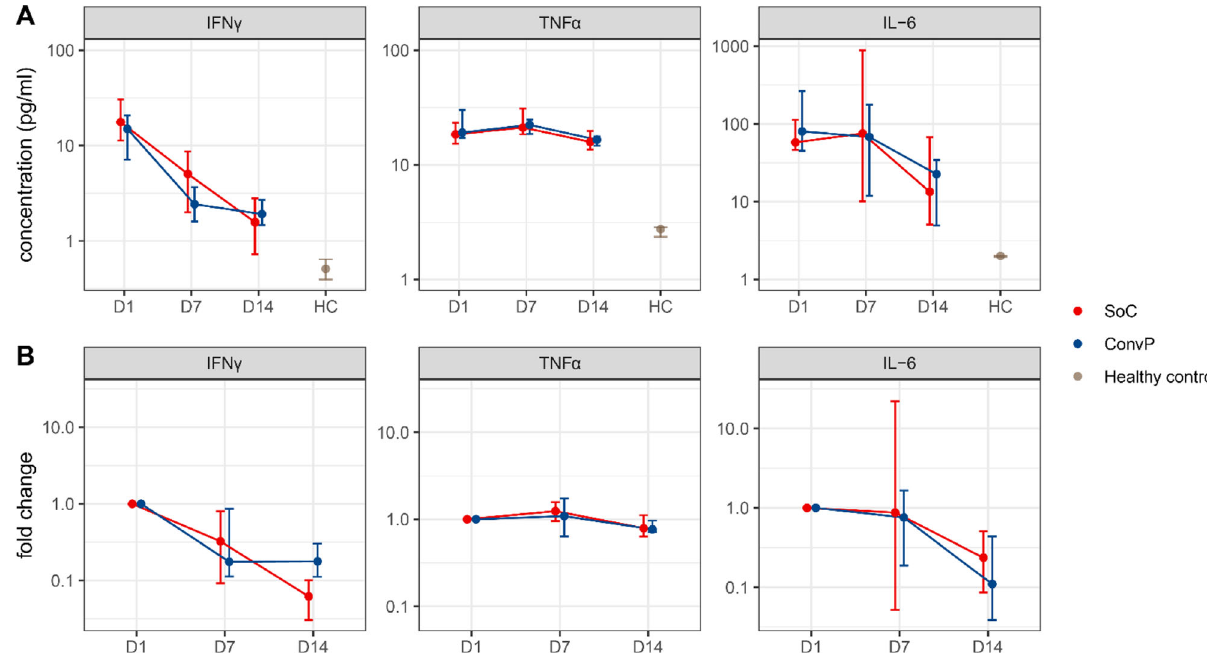
Fig. 7 IFN γ , TNF α , and IL-6 in patients and healthy controls. A Cytokine concentrations in serum. B Fold change. Cytokines IL-6, IFN γ , and TNF α were measured in the serum of nine convalescent plasma and ten standard of care patients (standard of care: red; convalescent plasma: blue) at enrollment (day 1) and on day 7 and day 14 after enrollment, and in the serum of healthy controls (brown). Dots represent median and vertical lines represent